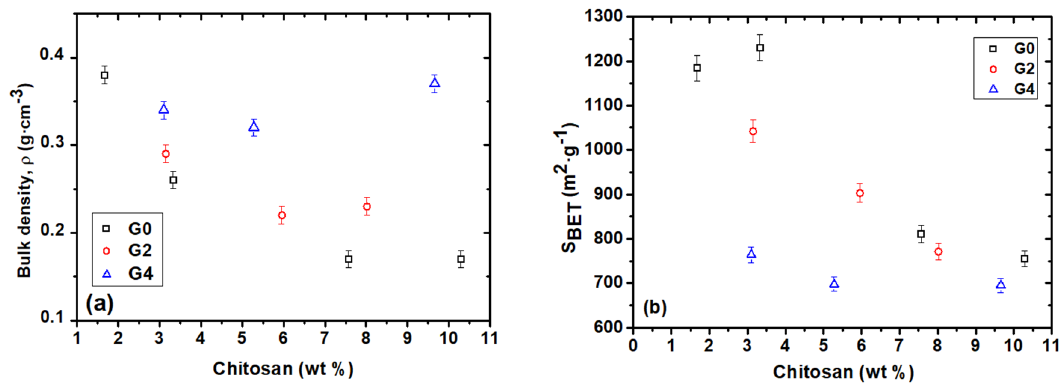
Figure 3. ( a ) Bulk density and ( b ) BET surface area of the CS-GPTMS-silica hybrids as a function of CS content (wt%) obtained from